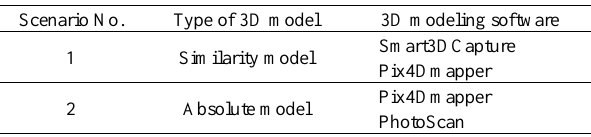
Table 3. 3D model and corresponding software used in each scenario